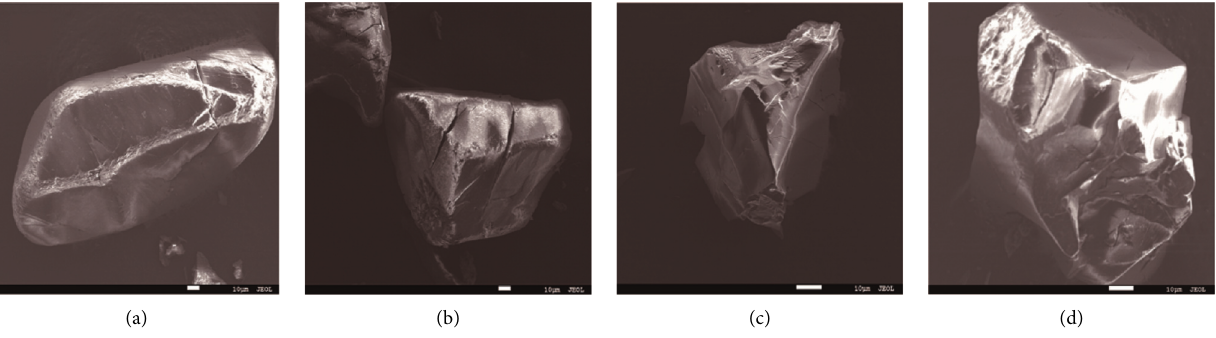
Figure 8: SEM images of Cu (I)-MOF before (a) and after Cr (VI) adsorption through (b) one cycle, (c) two cycles, and (d) three cycles.